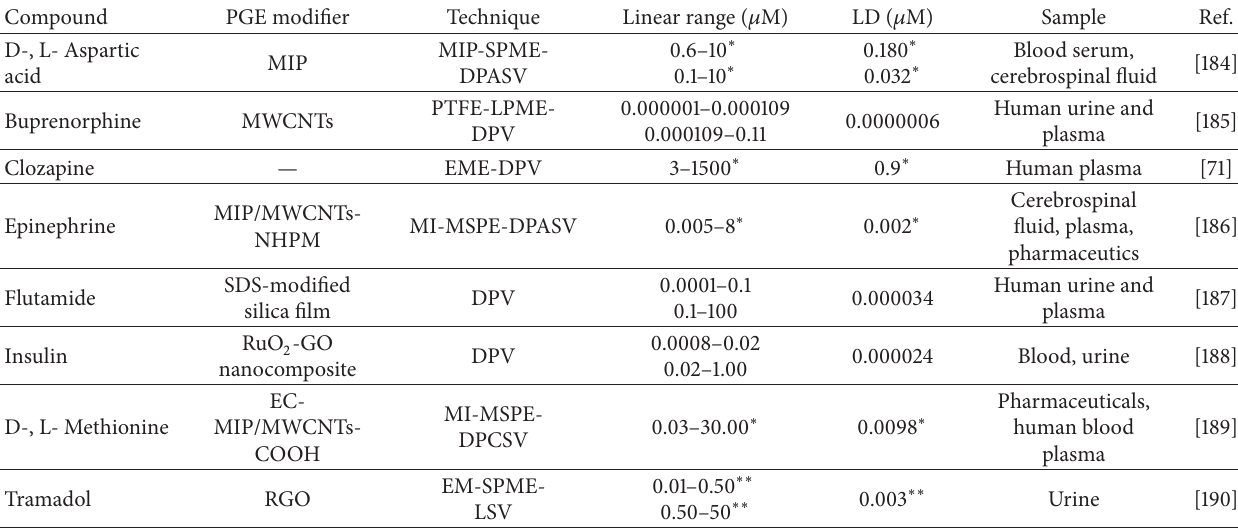
Table 4: PGE used in tandem with separation